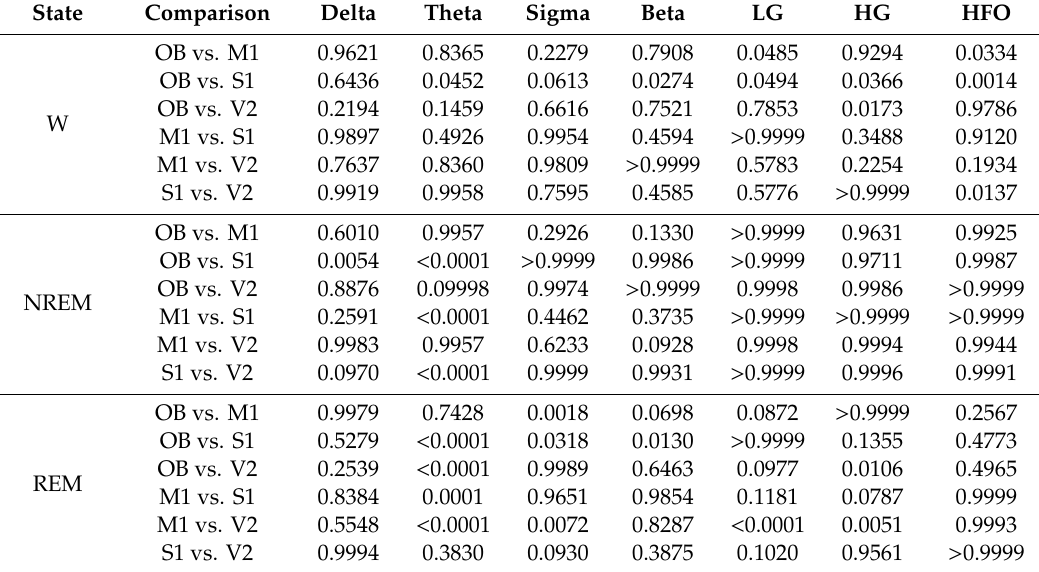
Table 3. Relative power. Sidak multiple comparison